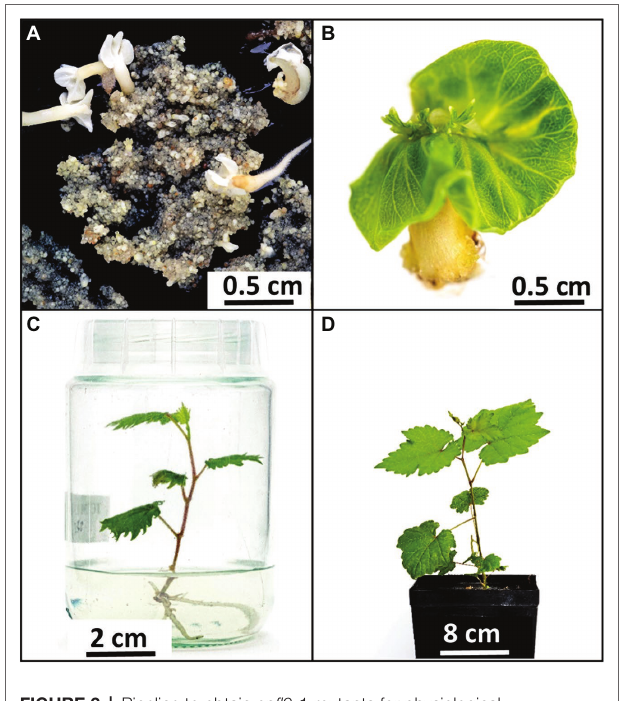
FIGURE 2 | Pipeline to obtain epfl9 -1 mutants for physiological characterization. (A) Embryogenic callus of ‘Sugraone’ 7 months after co- cultivation with Agrobacterium tumefaciens . Some embryos are developing on a homogeneous callus mainly formed by small globular embryos. (B) Embryo producing shoot. (C) In-vitro plantlet cultivated in baby jar. (D) Greenhouse plant after 2 months from acclimatization of an in-vitro plantlet.